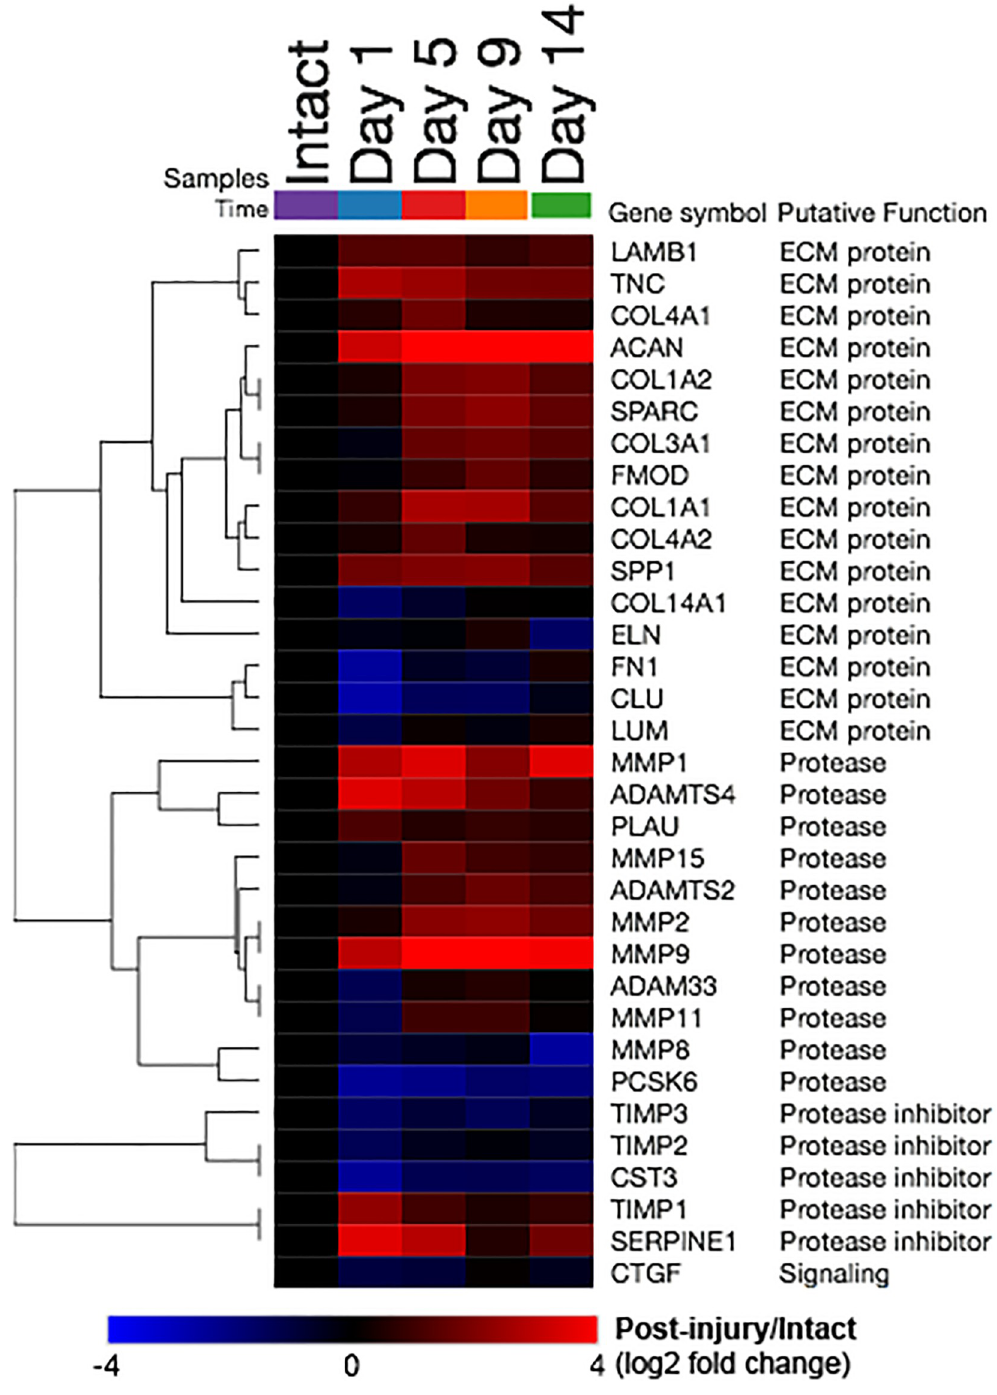
Fig 2. Proteolysis related gene expression changes ( Proteolysis_ECM remodeling process network). Heatmap depicting the relative transcript abundance levels compared to intact controls (log-2 fold change from the comparison of post-injury group means over the mean of the intact controls). Red indicates higher expression following injury, blue indicates lower expression, i.e. significant increases of MMP1 at 1, 5, 9, and 14 days post-injury were observed. All 33 transcripts (rows) differentially expressed in at least one of the assessed post-injury time-points were included (out of 83 total transcripts included in the process network).